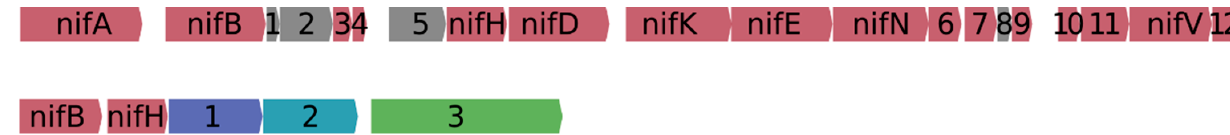
Figure 5. Nitrogen fixation operons. Top: common nitrogen fixation operon of three studied Rhodovulum species (“slow” operon): 1—4Fe-4S binding protein, 2—leucine rich repeat (LRR) pro-